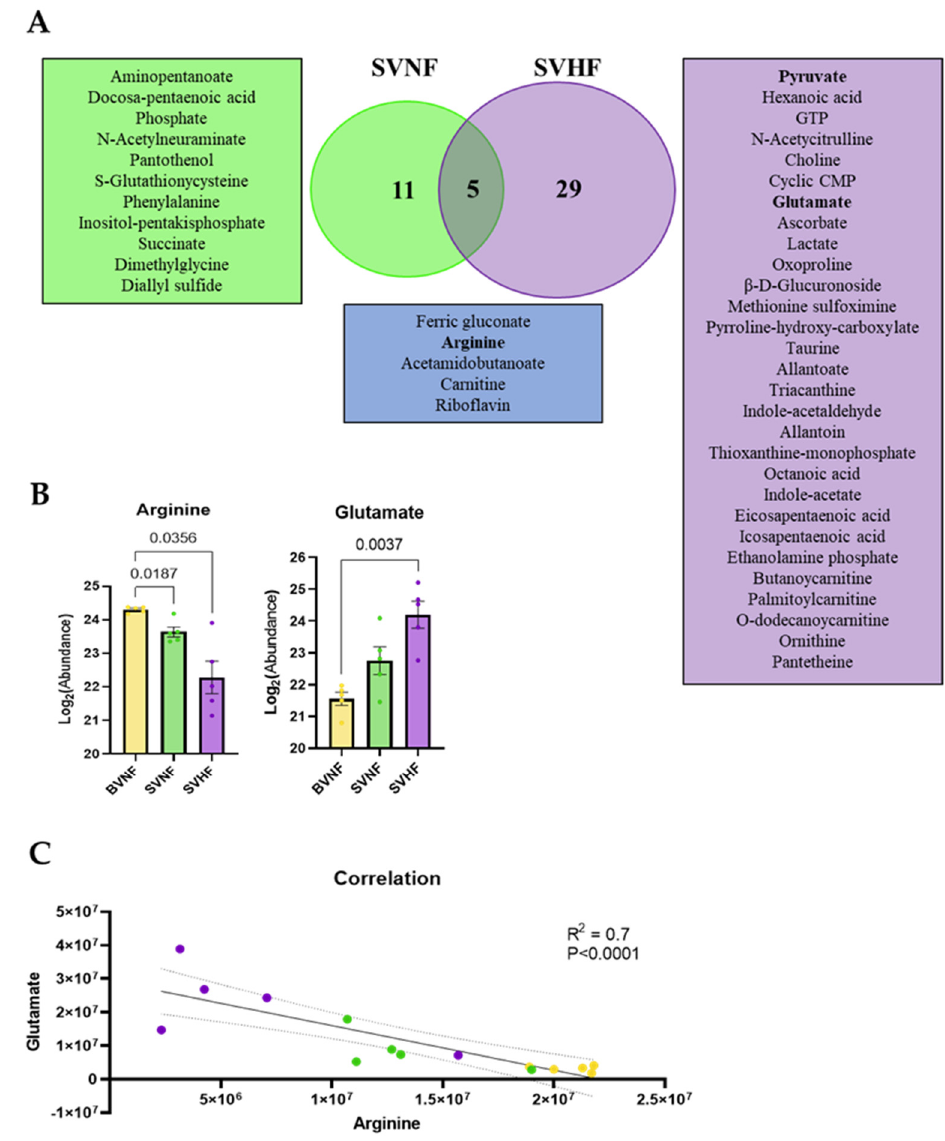
Figure 5. Common and unique metabolite profiles in SVNF and SVHF subjects. ( A ) Venn dendrogram of differentially expressed metabolites in each group. ( B ) Abundance of serum circulating arginine and glutamate in BVNF, SVNF and SVHF subjects. For all groups, bar equals mean ± SEM; each point represents individual patient values ( n = 5 BVNF, n = 5 SVNF and n = 5 SVHF subjects); p -values as indicated based on a one-way ANOVA (Welch’s) and Tukey’s multiple comparison test. ( C ) Correlation analysis between circulating levels of glutamate and arginine for all groups; dotted line is the 95% confidence interval; R 2 and p -value as indicated based on goodness of fit (solid line, R 2 ) and simple linear regression ( p -value).